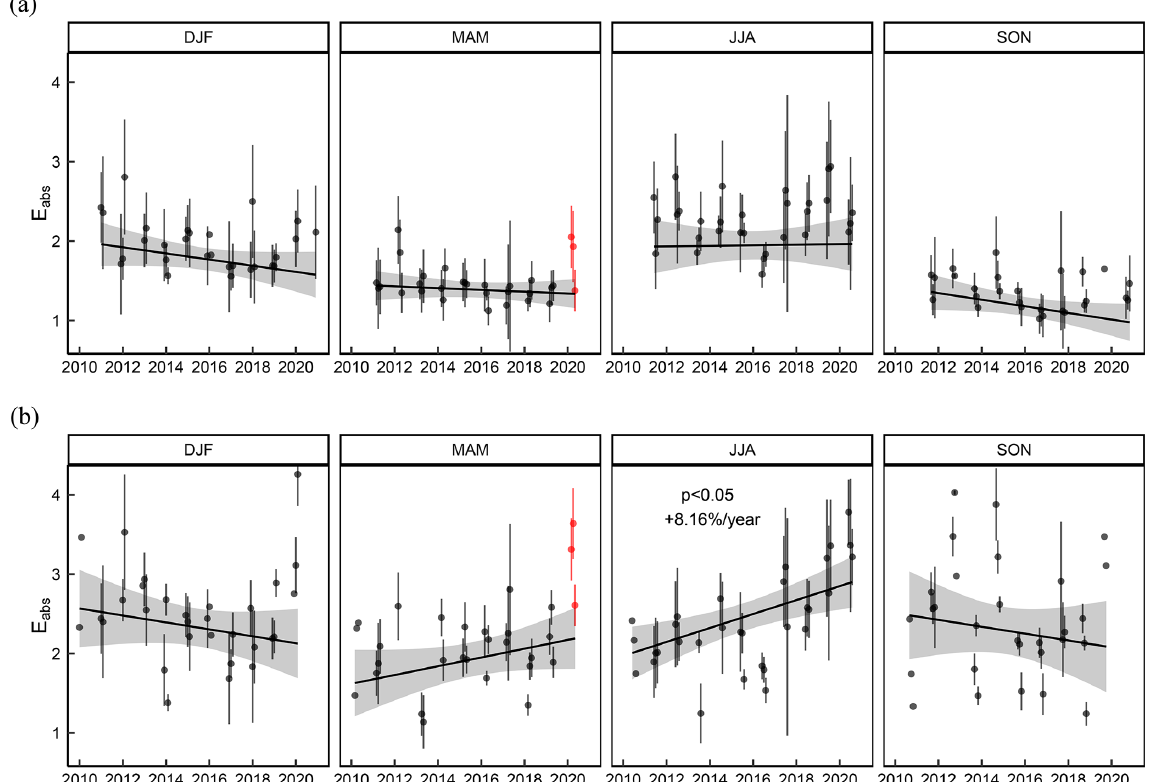
Figure 6. Absorption enhancement, E abs , at 637nm seasonal trend analysis between 2011 and 2020 at the (a) Barcelona and (b) Montseny station. The trend analysis was performed using a Theil–Sen function over the E abs offline